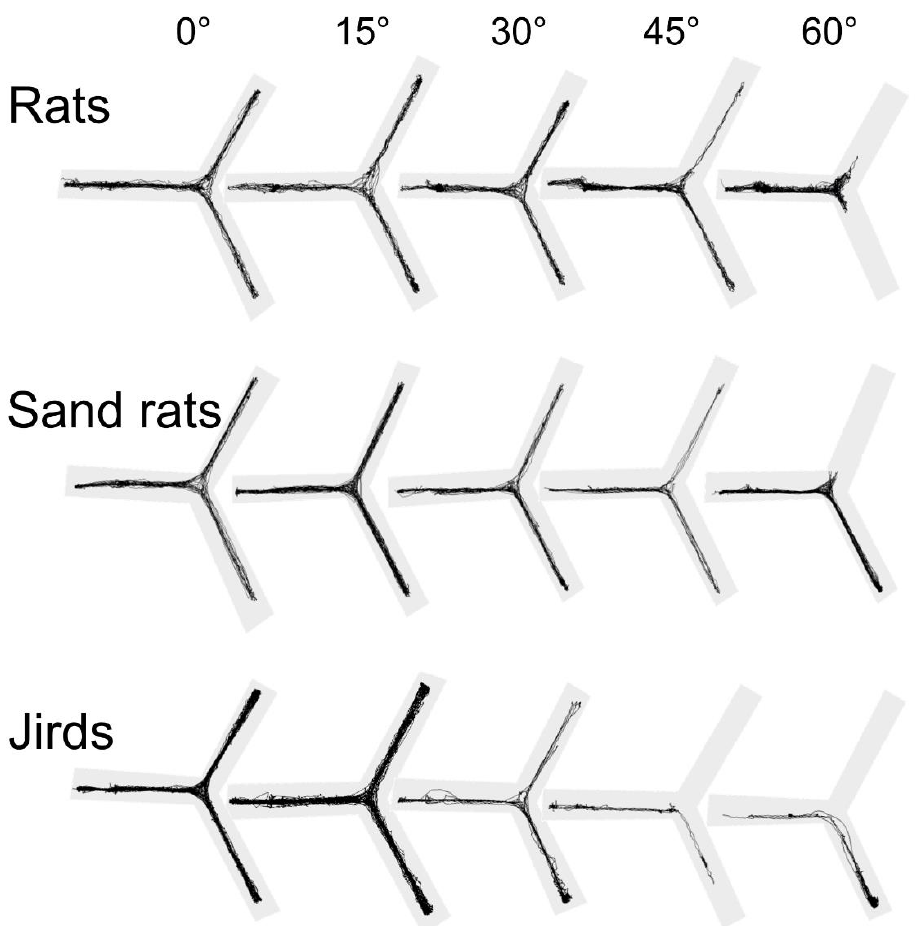
Figure 4. Exemplary trajectories of individuals of each species at each inclination. As shown, changes were subtle at the shallow inclinations of 15 ◦ and 30 ◦ compared with 0 ◦ . At the steep inclinations of 45 ◦ and 60 ◦ , the rats ceased to travel along the inclined arm, while the sand rats and jirds also did not enter the upper arm, but also spent less time in the lower arm.